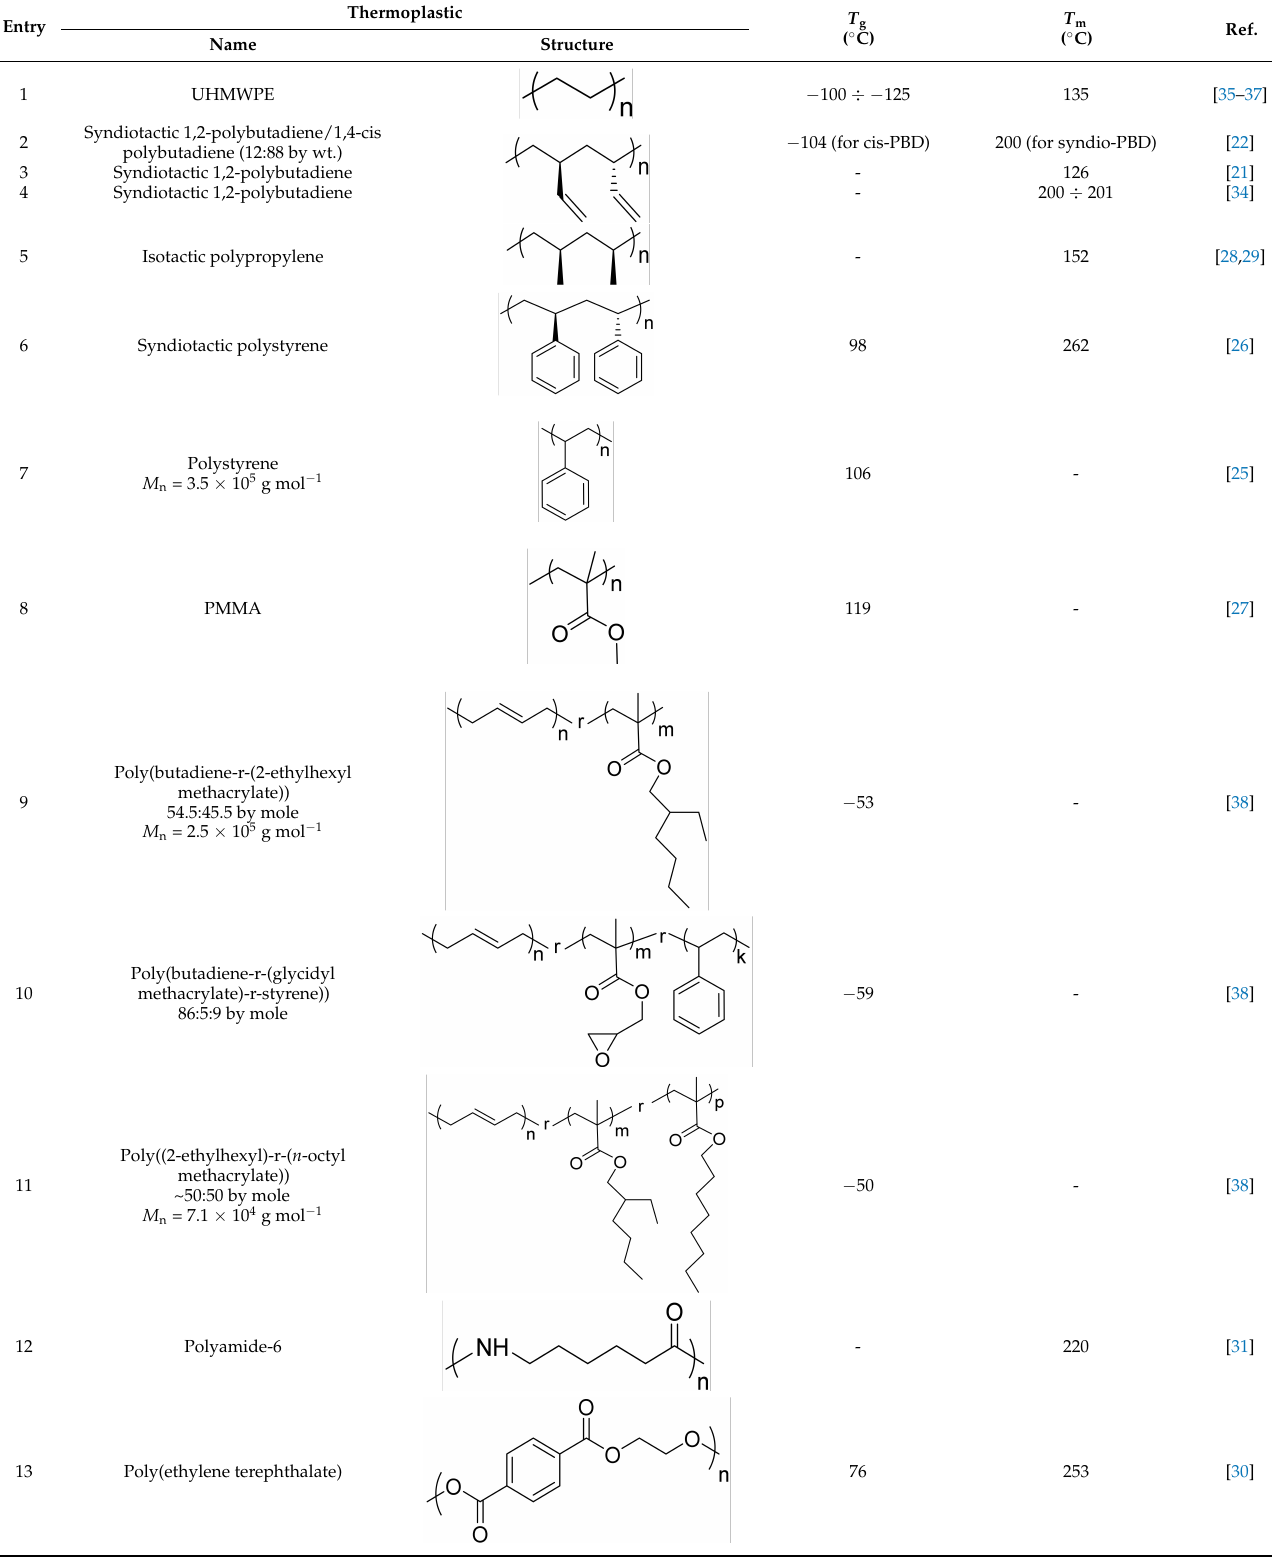
Table 1. Examples of the thermoplastics considered for the reinforcement of rubber compositions in various